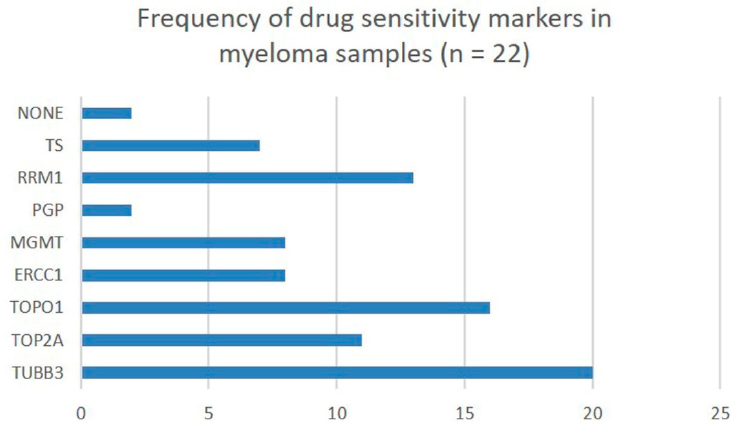
Figure 2. Various drug sensitivity biomarkers explored by immunohistochemistry in a cohort of 22 multiple myeloma patients. TS = thymidylate Synthase; RRM1 = tibonucleotide reductase M1; PGP = P-glycoprotein 1; MGMT1 = O 6 -alkylguanine DNA alkyltransferase; ERCC1 = excision repair cross-complementing group 1; TOPO1 = topoisomerase I; TOP2A = topoisomerase II α ; TUBB3 = class III β